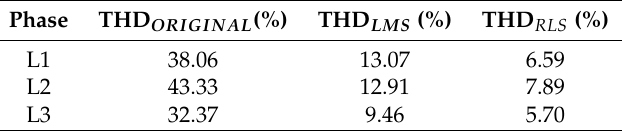
Table 3. THD values in switched on state before and after application of the adaptive LMS and RLS